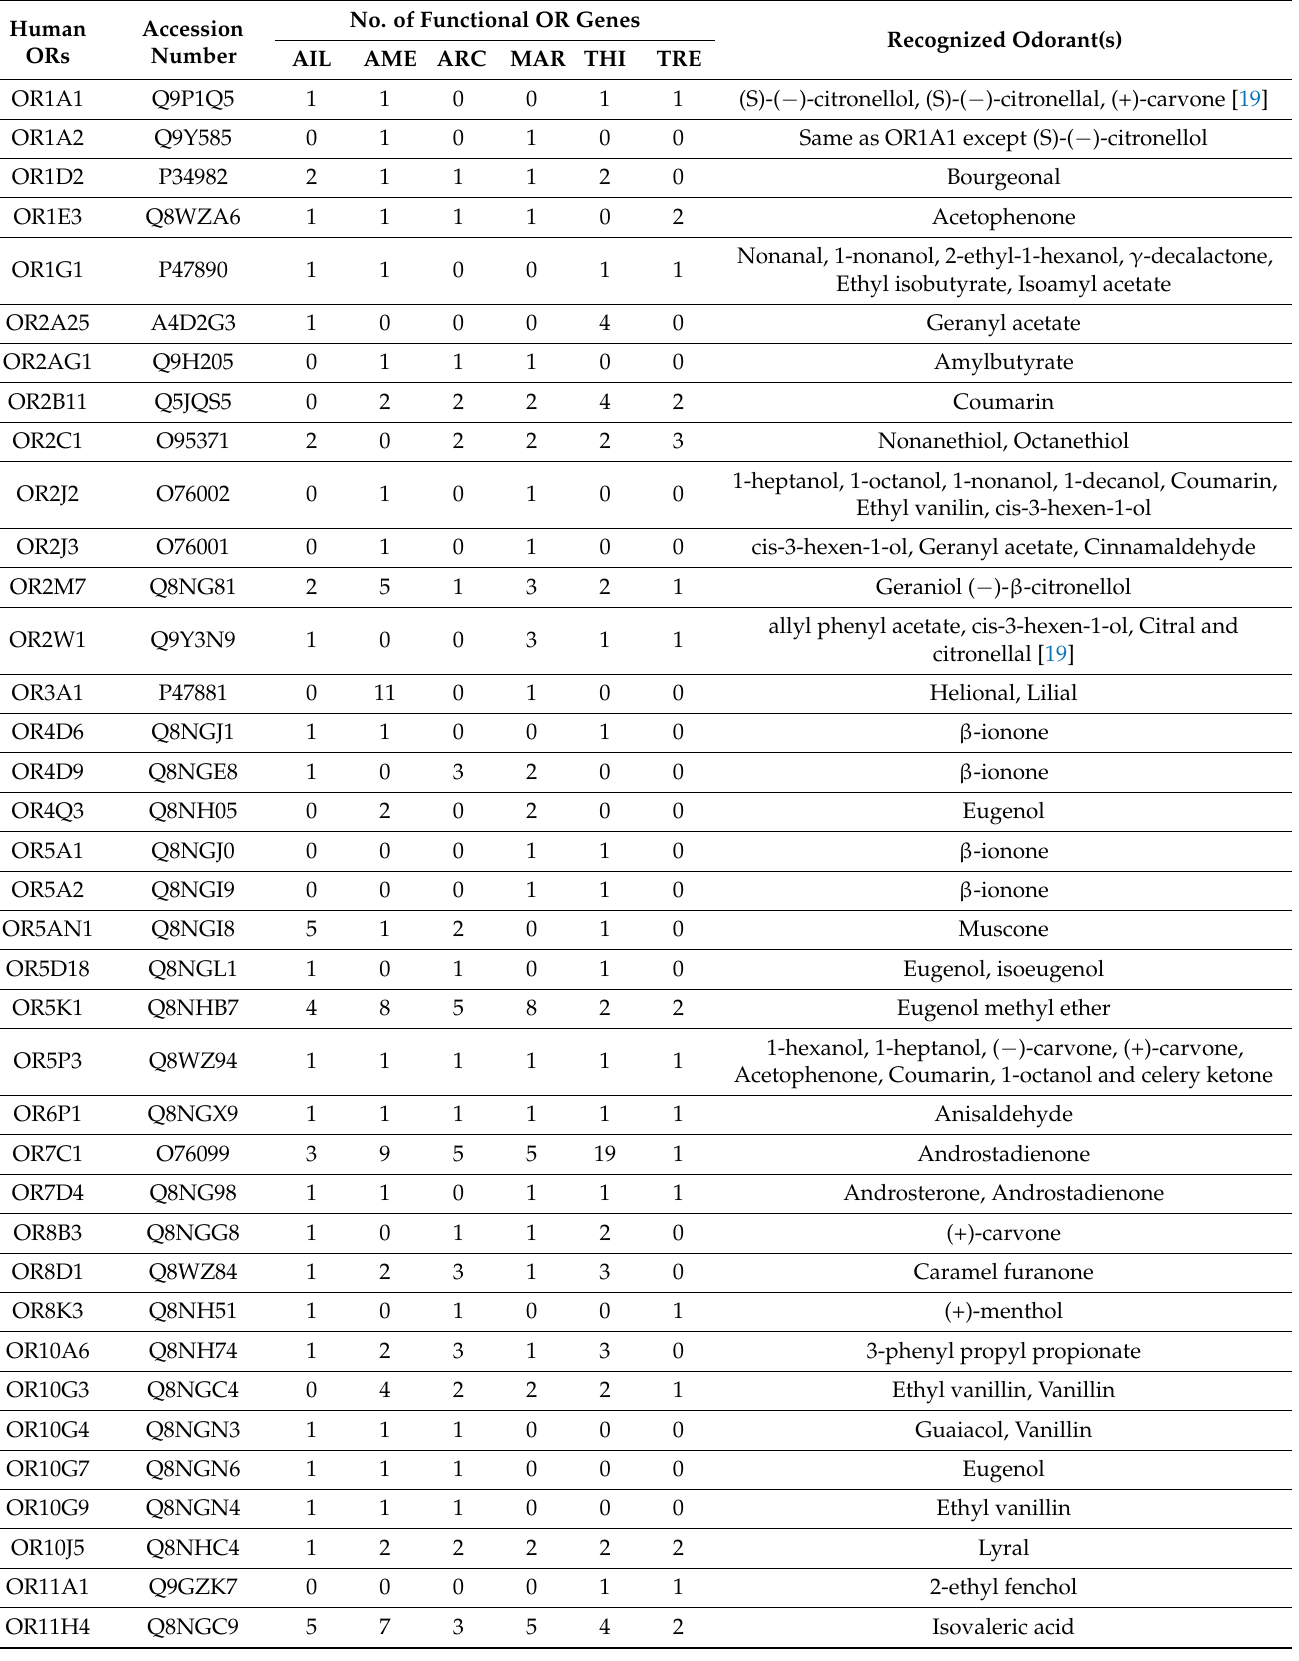
Table 3. Potential associations between Ursidae OR gene clusters and odorant